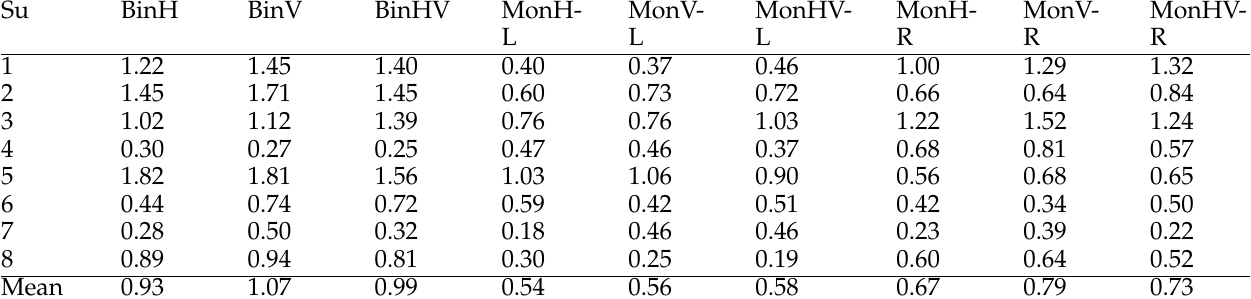
The average microsaccade frequency across the 2500ms interval around cue onset for each of the participants (numbered 1-8, ‘Su’ column). The columns labeled ‘BinH’, ‘BinV’ and ‘BinHV’ show the rates for binocular microsaccades for horizontal, vertical, and combined horizontal and vertical targets respectively. The remaining columns show the rates for uniquely monocular microsaccades in the different conditions for the two eyes (L=left,